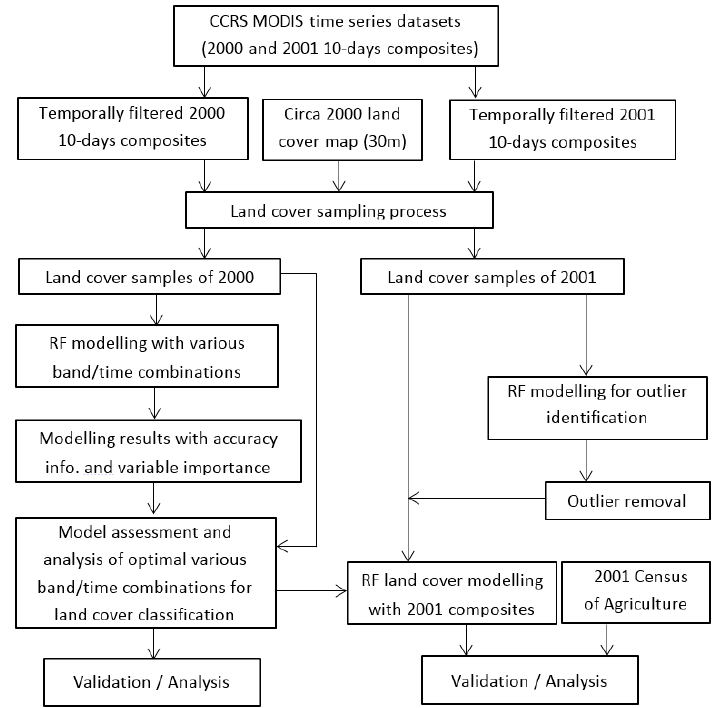
Figure 3. Overview outlining the key processing steps and datasets used in the analysis. CCRS: Canada Cetre for Remote Sensing; MODIS: Moderate Resolution Imaging Spectroradiometer; RF: Random Forests.